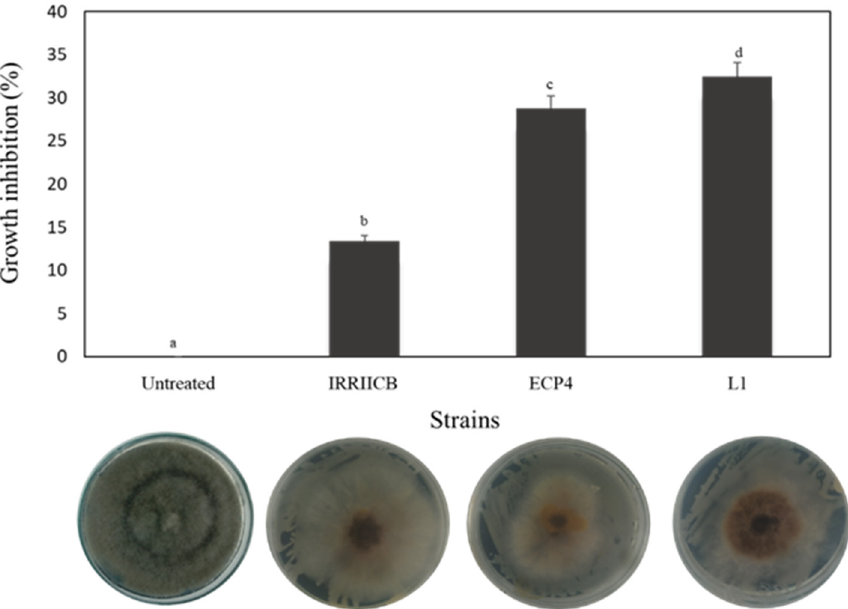
Figure 2. Effect of volatile organic compounds of Debaryomyces hansenii strains on the growth of B. cinerea . Different letters in the bars indicate significant differences between the strains a ( p < 0.05).